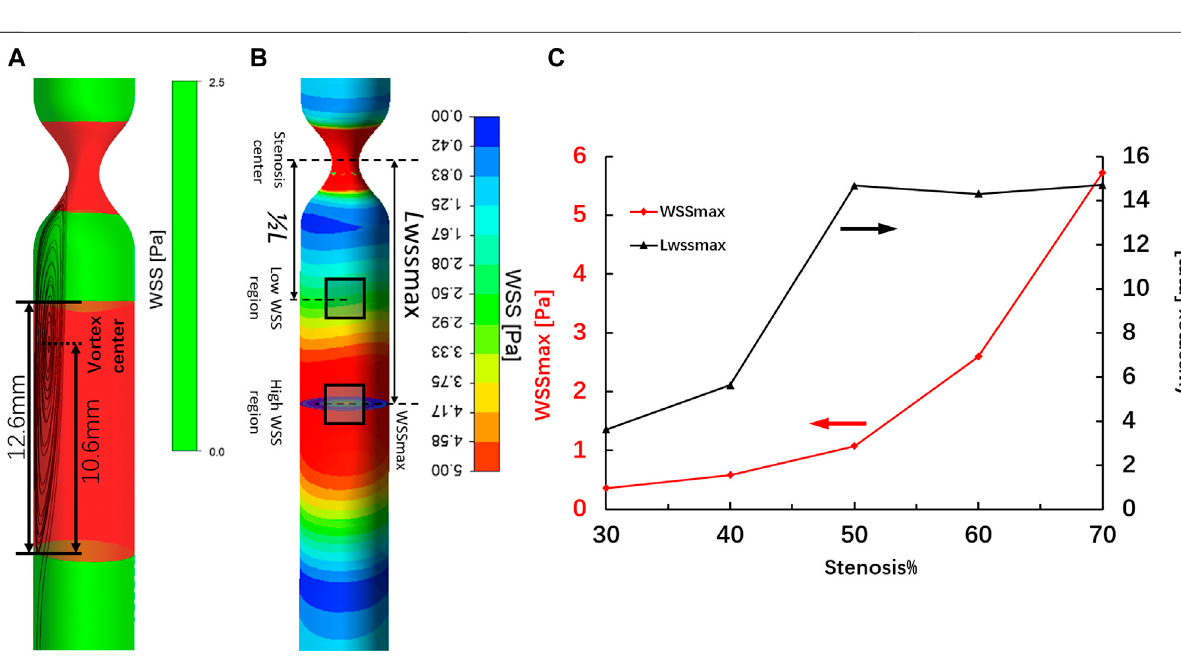
Frontiers in Bioengineering and Biotechnology |